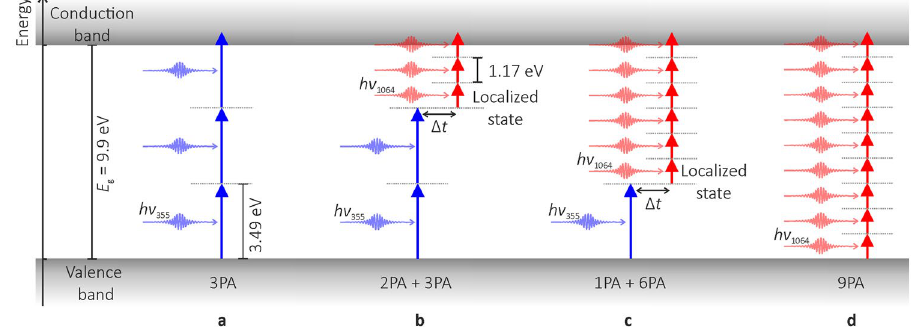
Figure 2. Absorption models of the dual-wavelength double-pulse irradiation. ( a ) 3PA of the UV pulse from the valence to the conduction band; ( b ) 2PA of the UV pulse to a localised state and 3PA of the IR pulse from the localized state to the conduction band; ( c ) 1PA of the UV pulse to a localized state and 6PA of the IR pulse from the localized state to the conduction band; ( d ) 9PA of the IR pulse from the valence to the conduction